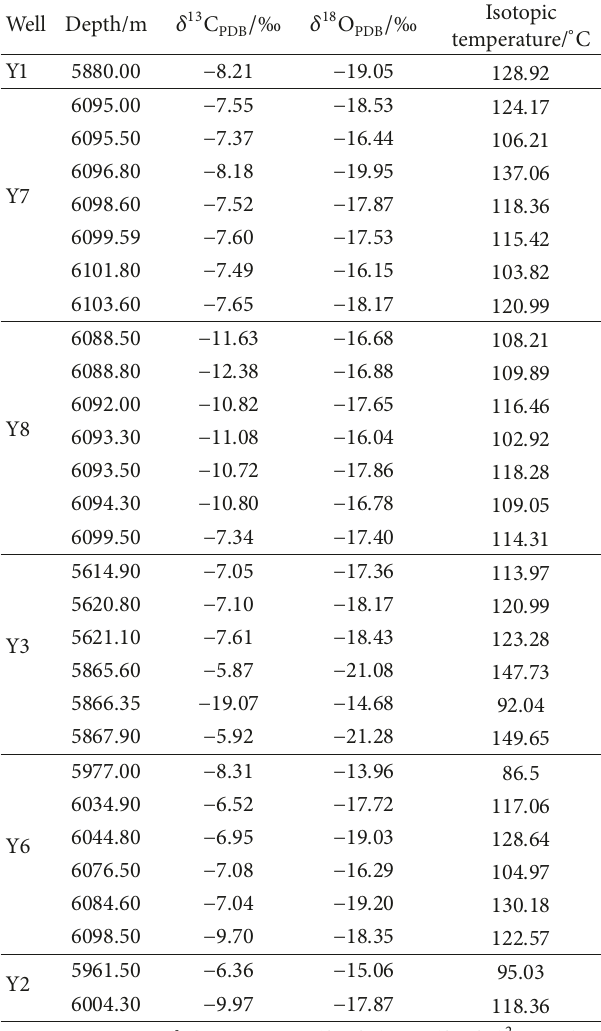
Table 2: Carbon and oxygen isotope values in Xishanyao formation sandstones of Block